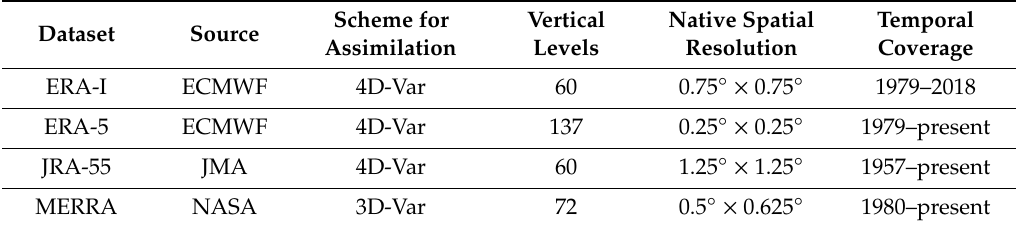
Table 1. Key characteristics of evaluated reanalyses in this